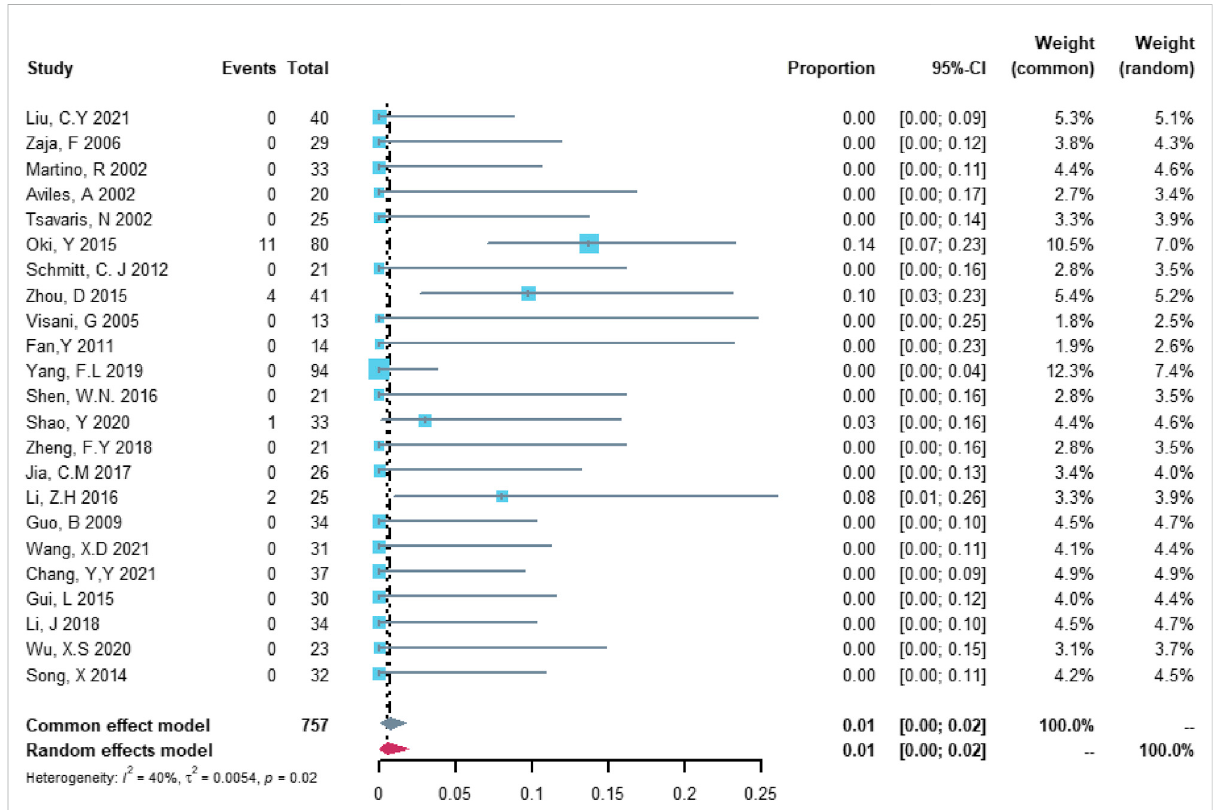
Figure 15; OR = 0.537, 95% CI = 0.323 – 0.894, and p = 0.017, Figure 16, respectively). These fi ndings indicated that the